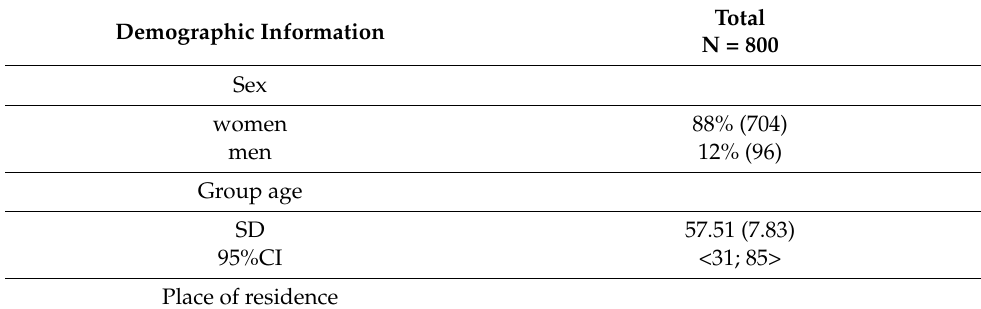
Table 6. Examined caregivers—descriptive